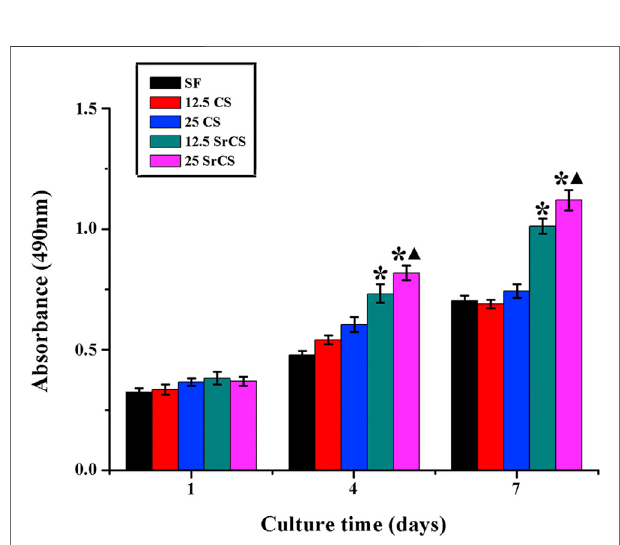
FIGURE4| MTTassay.Theeffectofdifferentmaterials(SF:SF,12.5CS: 12.5 wt% CS/SF, 25 CS: 25 wt% CS/SF, 12.5 SrCS: 12.5 wt% SrCS/SF, 25 SrCS: 25 wt% SrCS/SF) on the proliferation of rBMSCs. The SF group was treatedasthecontrolgroup. * p < 0.05 indicates theothergroups vs. the SF group, and ▲ p < 0.05 indicates the 25 SrCS group vs. the other groups.